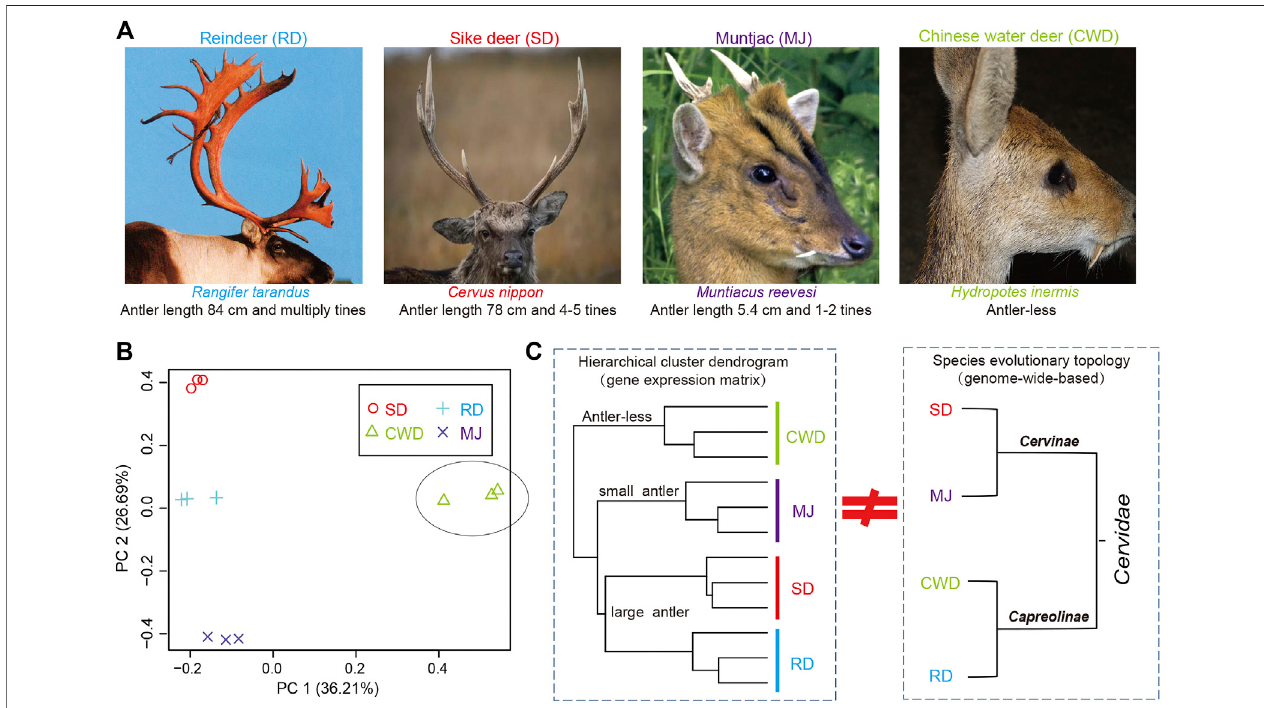
FIGURE 1 | (A) Antlers of three-antlered deer (ATD) species including reindeer (RD), sika deer (SD), and muntjac (MJ); and one antler-less deer species, Chinese waterdeer (CWD). (B) Principal component analysis (PCA) of the geneexpression of 12samples acrossfour deer species (three samples/species). (C) Left: hierarchical cluster analysis based on the gene expression matrix of 12 samples among four deer species; Right: evolutionary topology of four deer species obtained from the previous study (Chen et al.,